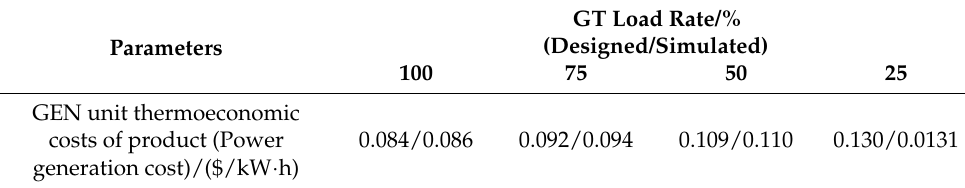
Table 8. Comparison of the unit thermoeconomic costs of product.